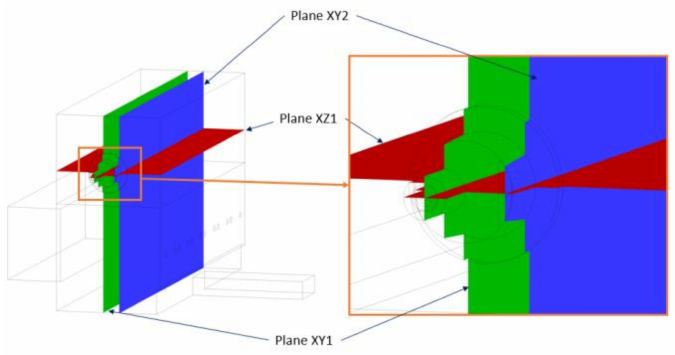
Figure 10. Surfaces used for